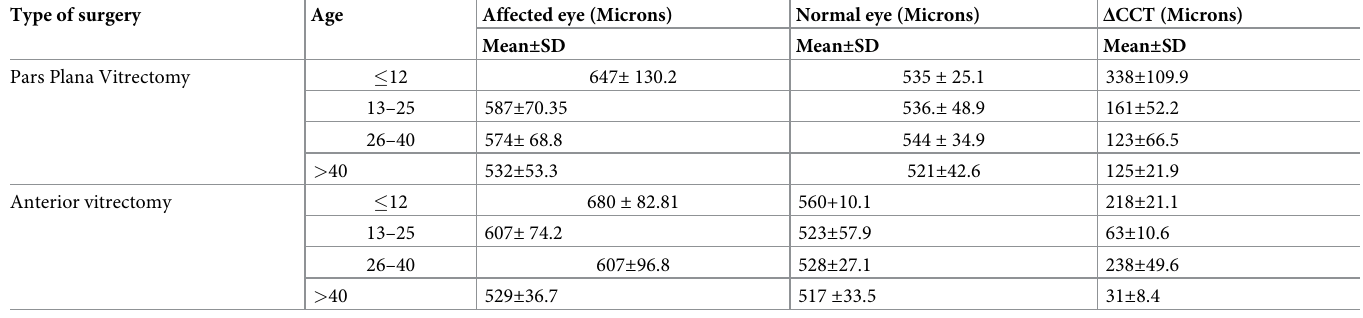
Table 2. Comparison of central corneal thickness and Δ CCT in eyes undergoing anterior and posterior vitrectomy (See text for details of Δ CCT description and sig- nificance levels of comparisons). Type of surgery